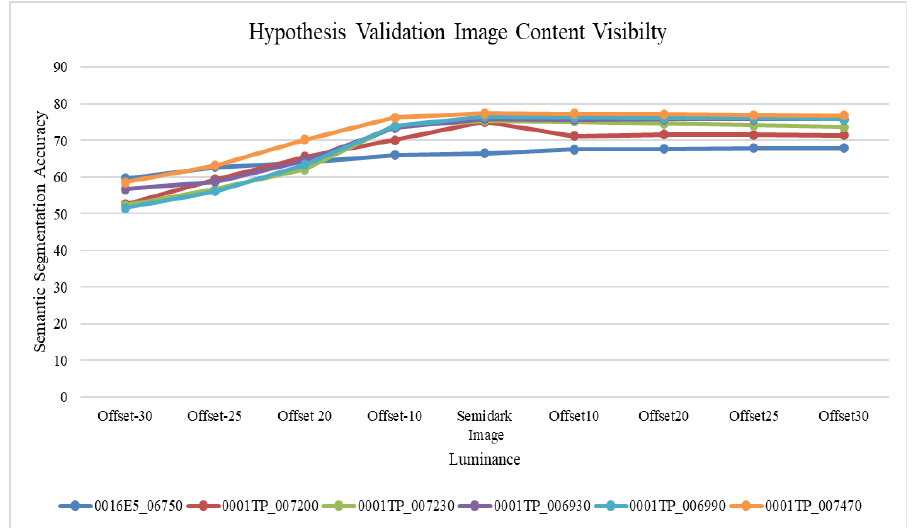
Figure 2. Hypothesis